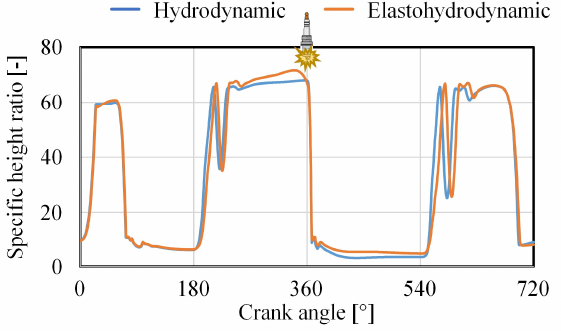
Figure 11. Piston thrust side minimum oil film thickness dependent on the crankshaft angular position.